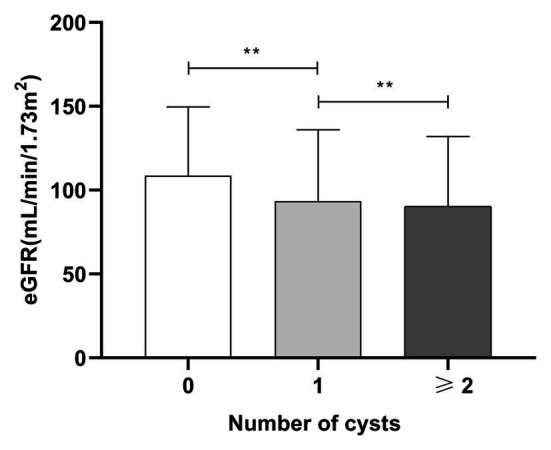
The relationship between numbers of SRCs and eGFR in patients with type 2 diabetes. Mean ± standard deviation: no SRCs group: 108 ± 40.93 ml/min/1.73 m2, one SRC: 93.53 ± 42.5 ml/min/1.73 m2, and more than two SRCs: 90.34 ± 41.72 ml/min/1.73 m2. SRC, simple renal cysts; eGFR, estimated glomerular filtration rate; **p < 0.01. Error bars indicate standard errors.